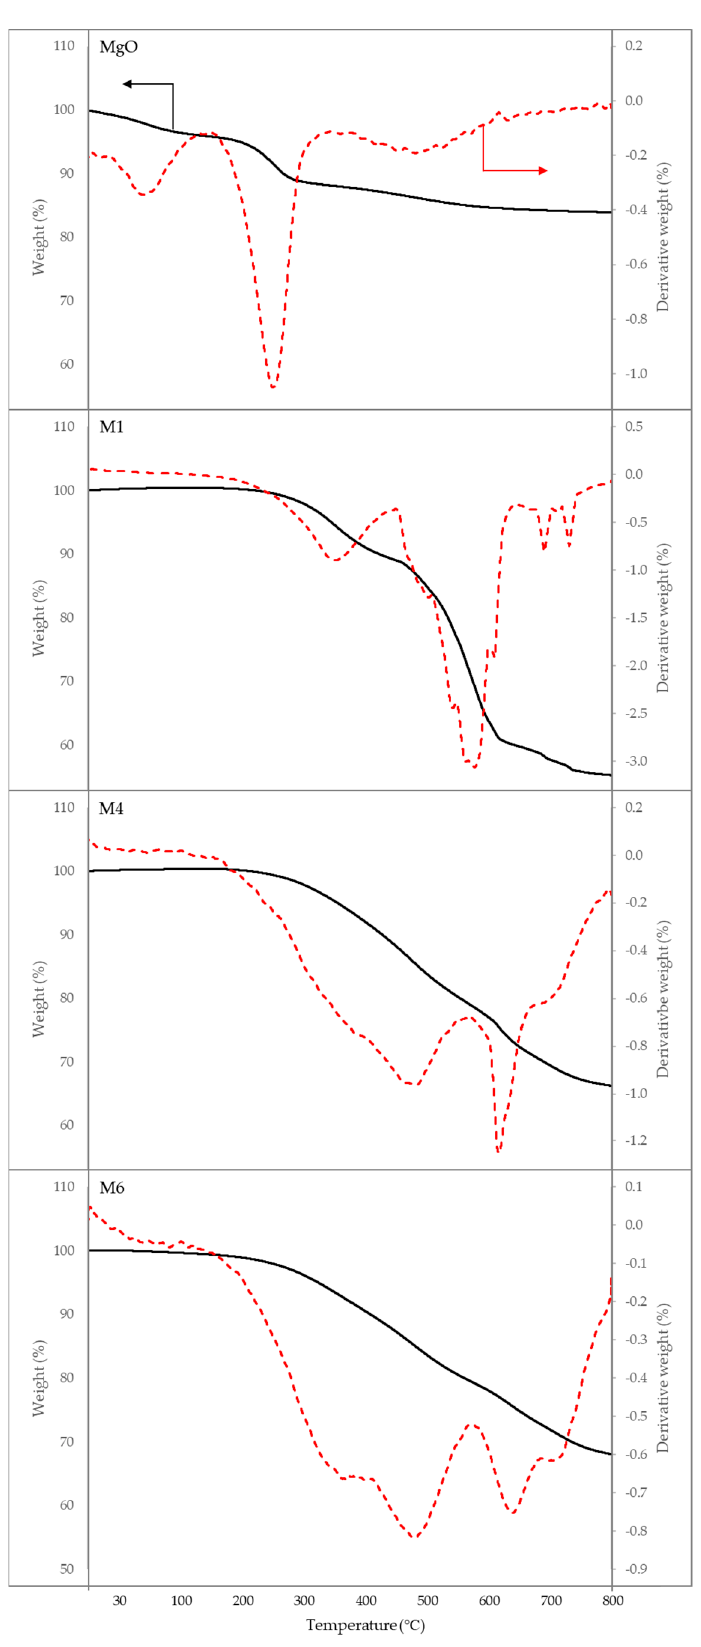
Figure 5. Thermal gravimetric analysis (TGA) and derivative thermogravimetric (DTG) curves of PDMS and PDMS/MgO membranes.